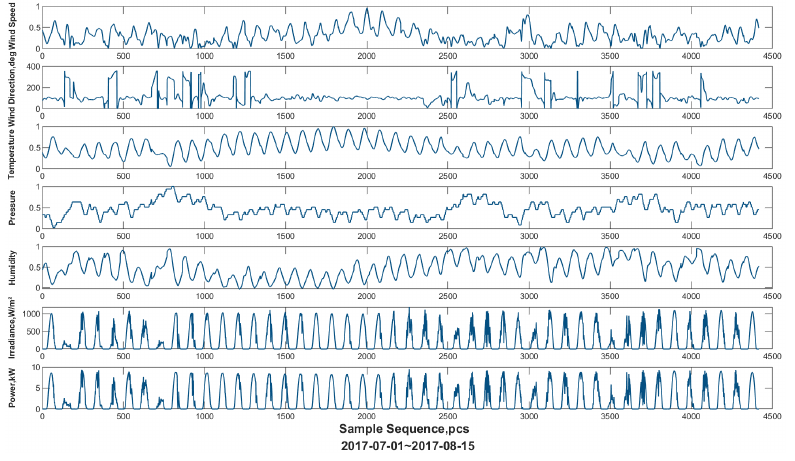
Figure 1. Time series diagram of preprocessed